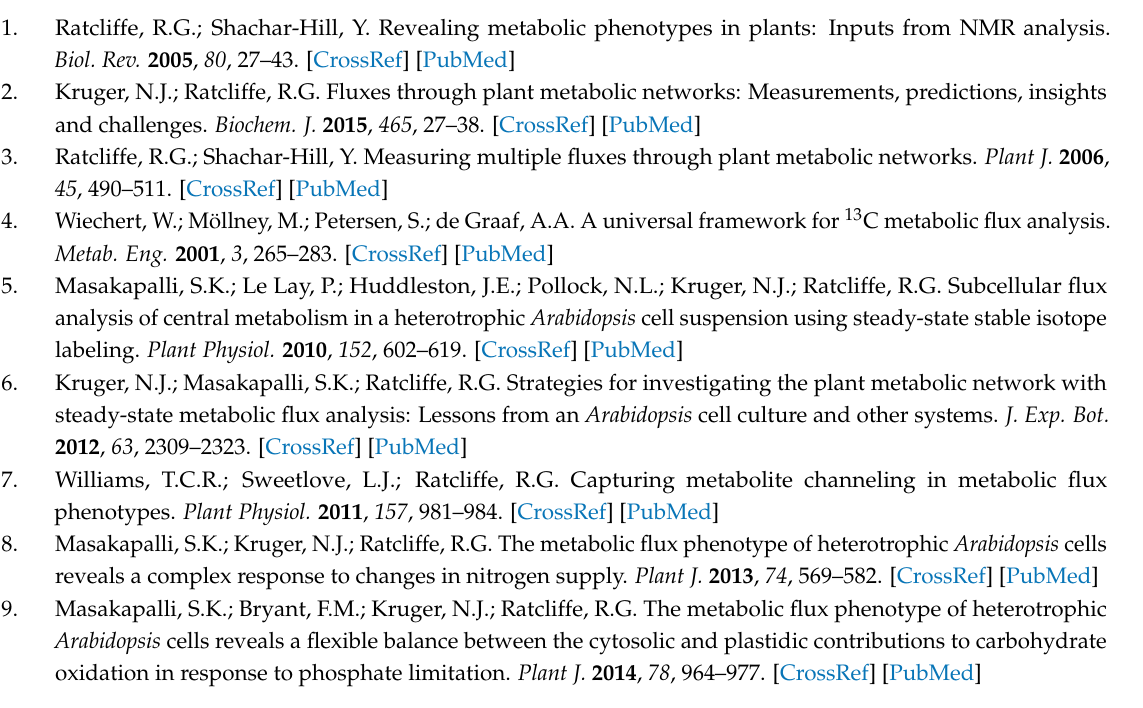
Table S5: Summary of deduced fluxes determined from simulated mass isotopomer distributions, Table S6: Accuracy of flux estimates across an extended range of heterogeneous networks of primary carbon metabolism, Table S7: Flux estimates derived by combining isotopomer data from networks supporting variations in specified fluxes, Table S8: Comparison of average 13 C fractional abundance of amino acid fragments derived from purified GFP and the total protein